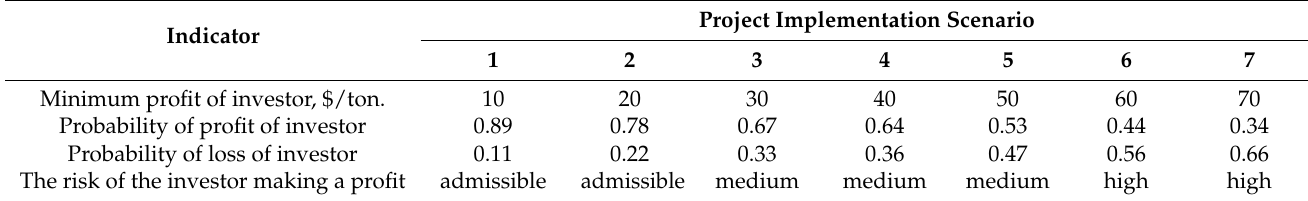
Table 1. Results of determination of the forecasted quantitative indicators of risk of profit R ( P s ) of investors in projects of production of raw materials for bioethanol from wheat for conditions of the Western region of Ukraine. Indicator Minimum profit of investor, $/ton.